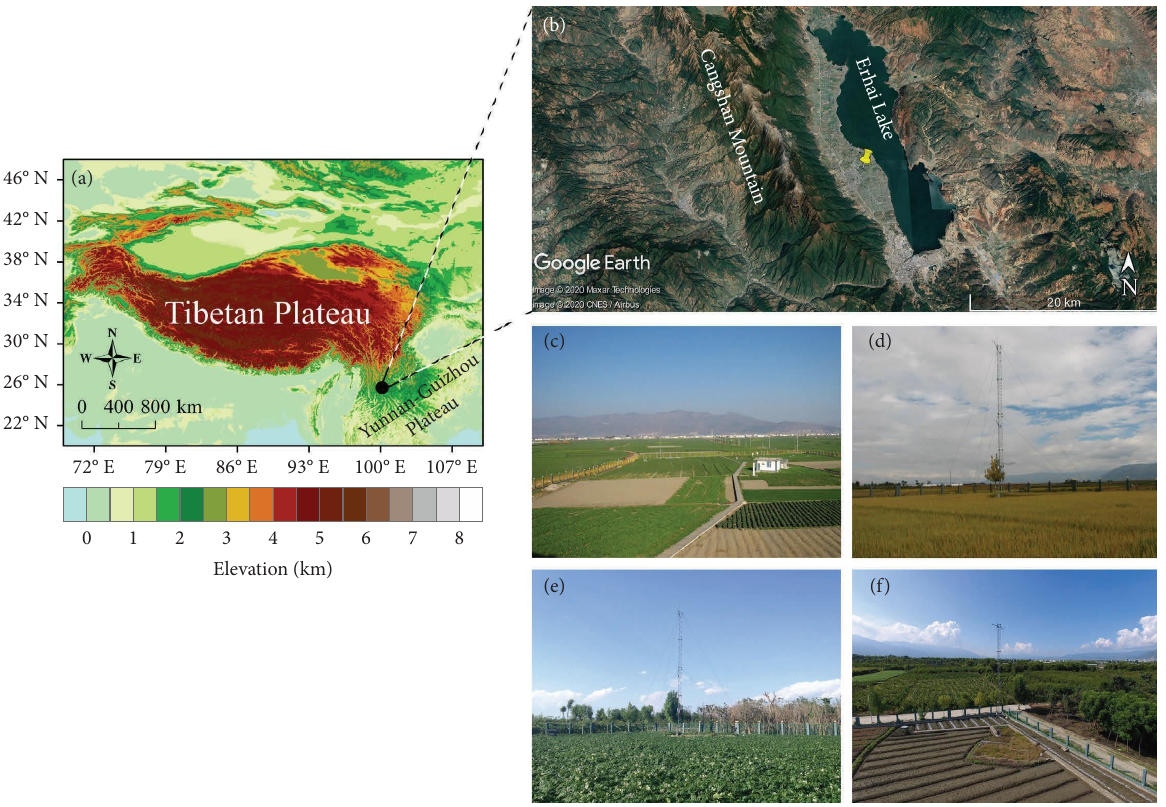
Figure 1: (a) Topographic map of the Tibetan Plateau (TP) and Yunnan-Guizhou Plateau (YGP), (b) location of the study area (map from Google Earth), pictures taken on 16 January 2009 (c), 26 September 2010 (d), 10 April 2016 (e), and 17 August 2016 (f) of the Dali fux